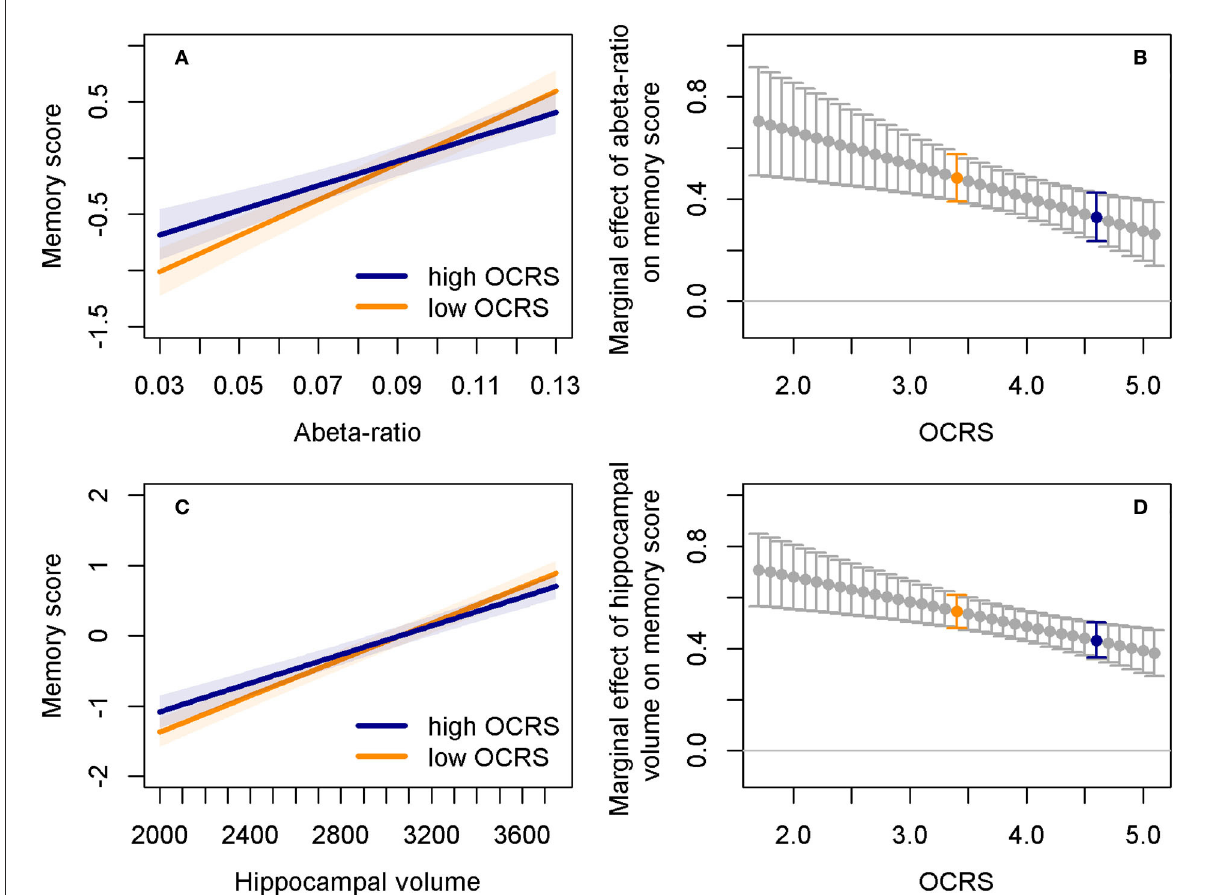
FIGURE3 Interaction effects of OCRS with A β 42/40 ratio and hippocampal volume regarding cross-sectional memory function. (A) Predicted memory factor scores depending on A β 42/40 ratio in individuals with either low (25th percentile, orange line) or high (75th percentile, blue line) OCRS levels. Shaded areas indicate 95% confidence intervals. (B) Marginal effects of the A β 42/40 ratio depending on OCRS levels. Bars indicate 95% confidence intervals. Marginal effects indicate the change in the memory factor when the A β 42/40 ratio increases by one standard deviation. It is computed as the sum of the coefficients of the A β 42/40 ratio and the A β 42/40 ratio*OCRS interaction term. Blue dots and bars correspond to the predicted trajectory for individuals with high OCRS (blue line) in plot (A) . Orange dots and bars correspond to the predicted trajectory for individuals with low OCRS (orange line) in plot (A) . Marginal effects indicate that effects of A β 42/40 ratio on memory function are stronger at lower levels of the OCRS. (C) Predicted memory factor scores depending on the averaged left and right hippocampal volume in individuals with either low (25th percentile, orange line) or high (75th percentile, blue line) OCRS levels. Shaded areas indicate 95% confidence intervals. (D) Marginal effects of the hippocampal volume depending on OCRS levels. Bars indicate 95% confidence intervals. Interpretation analogous to (B)